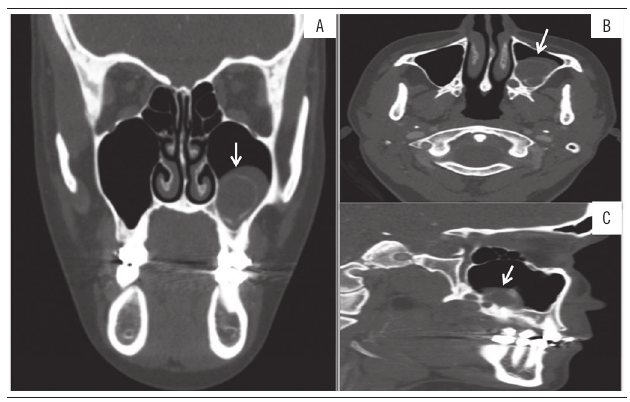
figurE 2 − Computed tomography A) coronal section; B) axial section; C) sagital section.